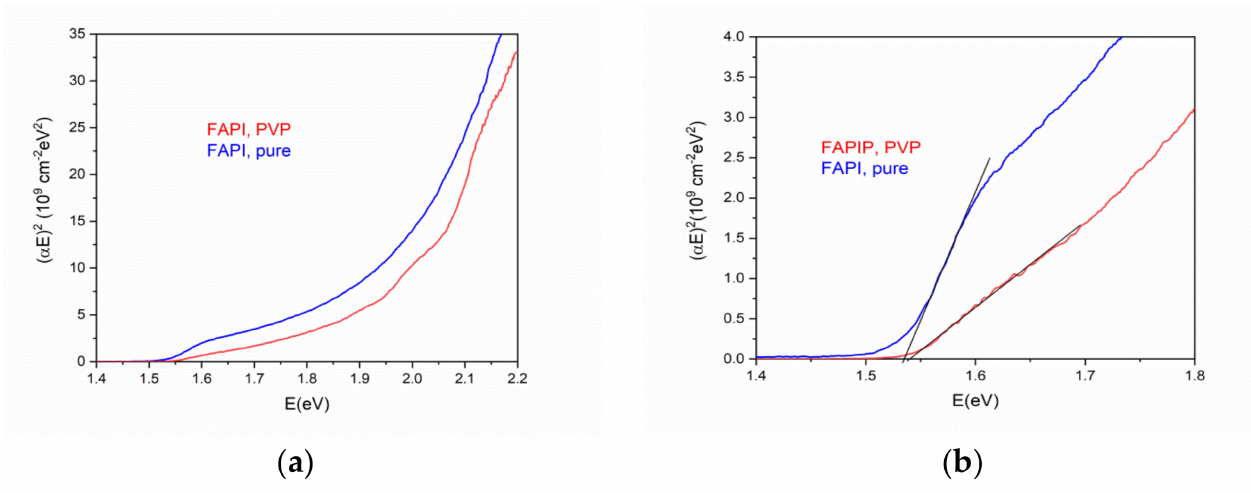
Figure 9. ( a ) The plots of ( α E ) 2 vs photon energy E for FAPI perovskite with and without PVP ( b ) zoomed region of the Tauc plot used for the bandgap E g